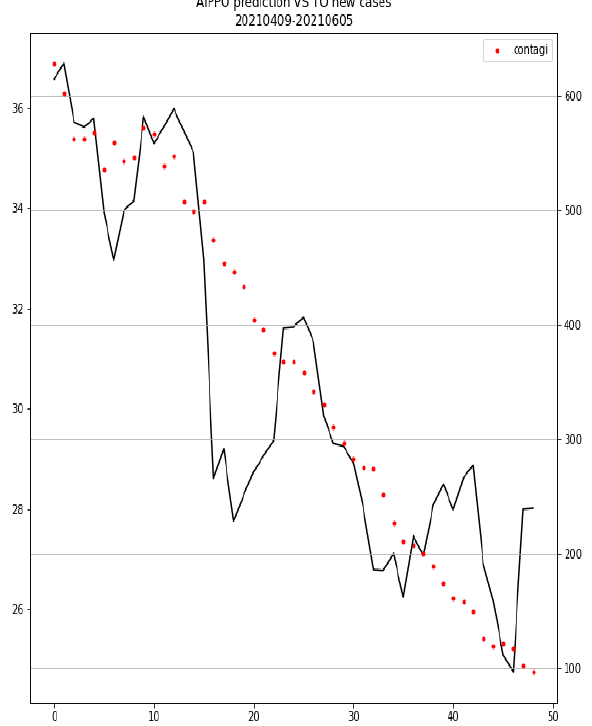
Figure 10. The 7 day rolling average comparison between AIppo COVID-19 score and Provincia di Torino daily new cases. Solid line indicates AIppo prediction, dots local new cases. Primary vertical axis (left): 7 day rolling average for AIppo score (in percentage), secondary vertical axis (right): 7 day rolling average for local new cases, horizontal axis: days.